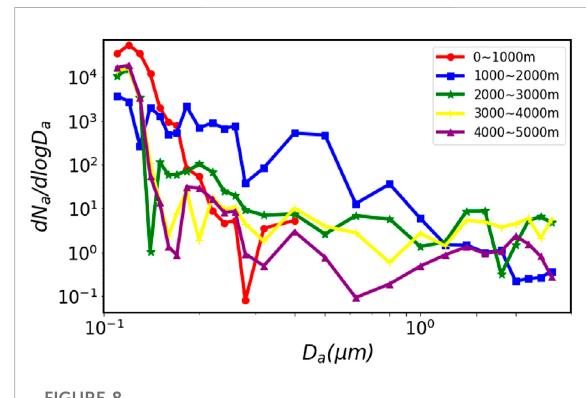
FIGURE 8 Aerosol size spectrum at different cloudless